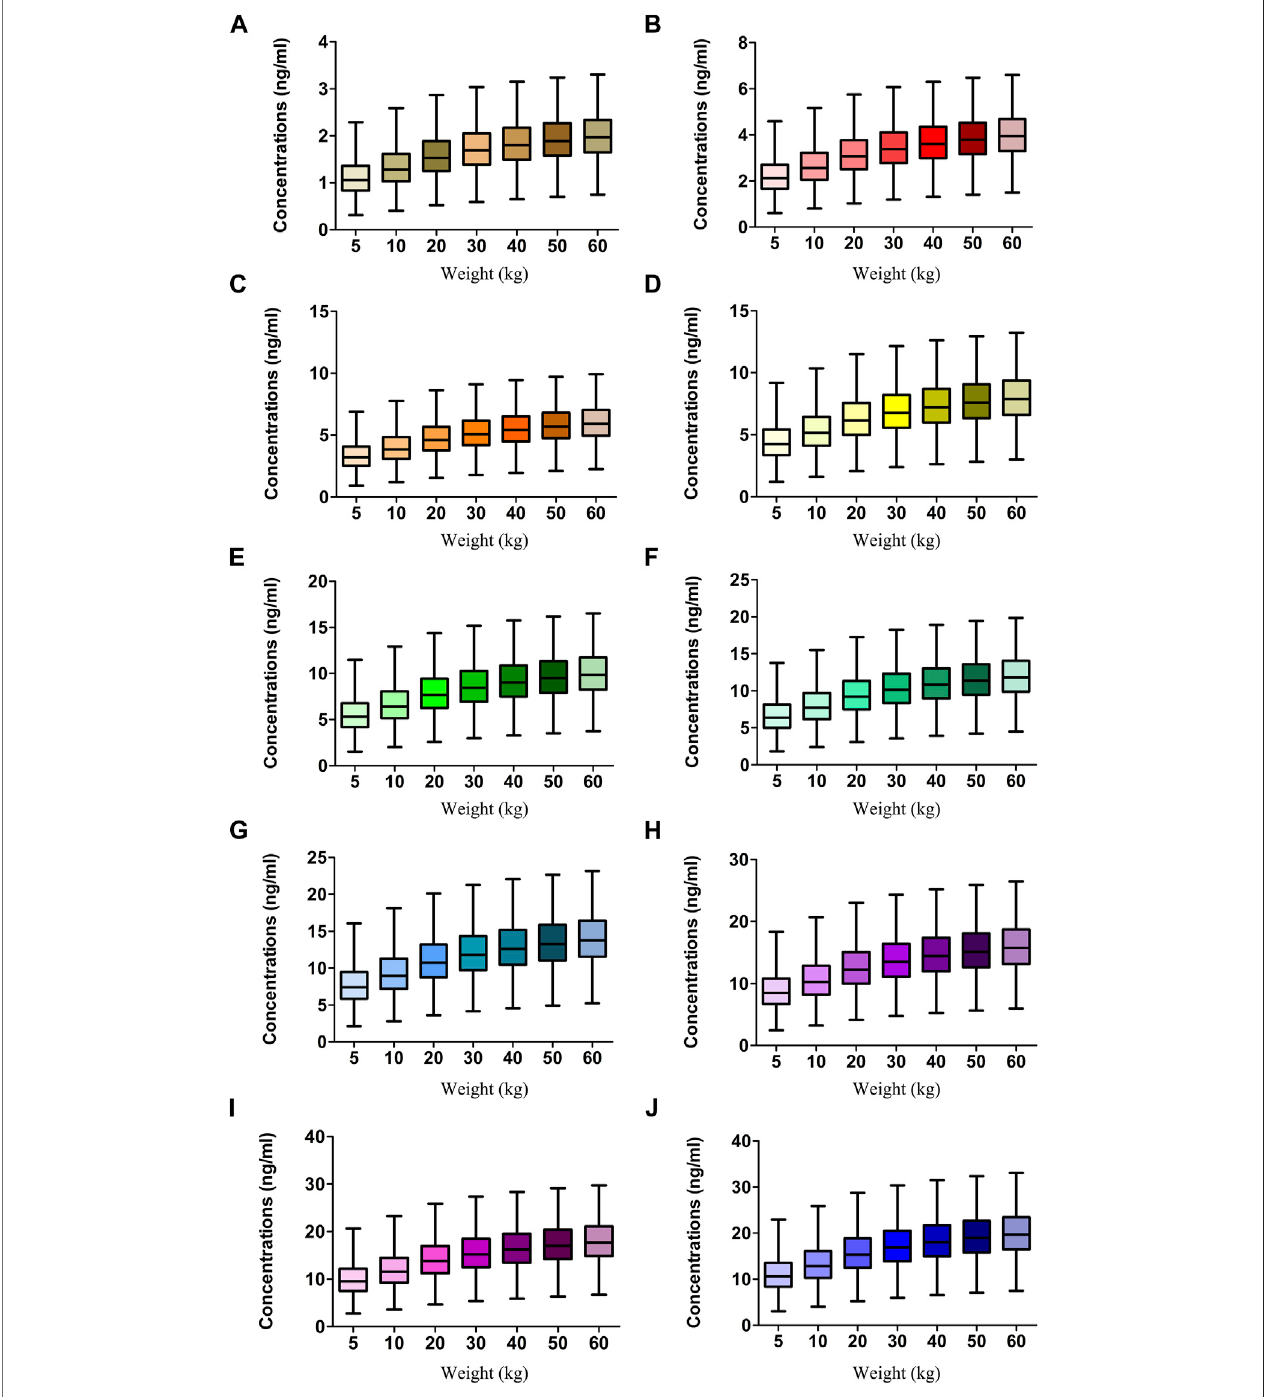
FIGURE 3 | Simulation of sirolimus concentrations. (A) 0.01 mg/kg/day sirolimus dose. (B) 0.02 mg/kg/day sirolimus dose. (C) 0.03 mg/kg/day sirolimus dose. (D) 0.04 mg/kg/day sirolimus dose. (E) 0.05 mg/kg/day sirolimus dose. (F) 0.06 mg/kg/day sirolimus dose. (G) 0.07 mg/kg/day sirolimus dose. (H) 0.08 mg/kg/day sirolimus dose. (I) 0.09 mg/kg/day sirolimus dose. (J) 0.10 mg/kg/day sirolimus dose. The sirolimus regimen was splited evenly into two dosages a